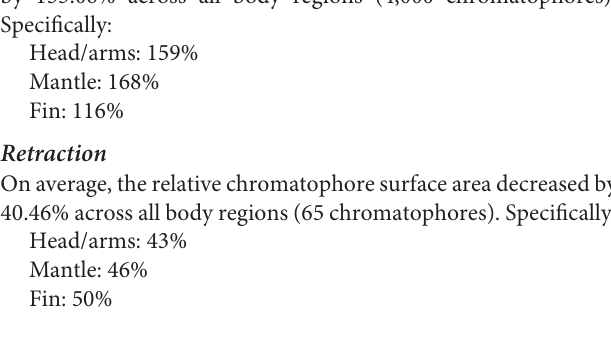
chromatophore surface area (RCSA) with the pre-flash baseline chromatophore surface area (BCSA) ( Figure 3